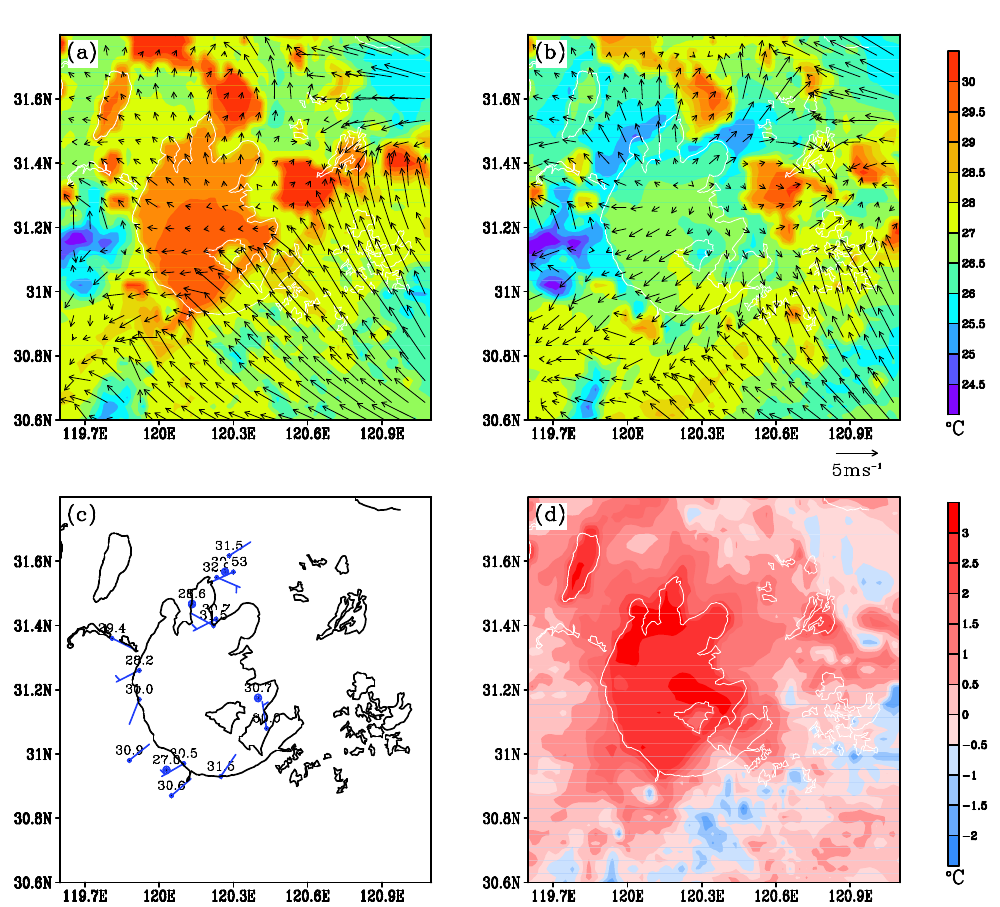
Figure 8. Modelled the wind vector, and the air temperature at 2 m at 19:00 19 July 2012 ( a ) by S‑Lake; ( b ) by D-Lake; ( c ) observed by meteorology station; ( c ) Observation by sites. The long pole is 4 m s − 1 and the short pole is 2 m s ; ( d ) difference between S‑Lake and D‑Lake.